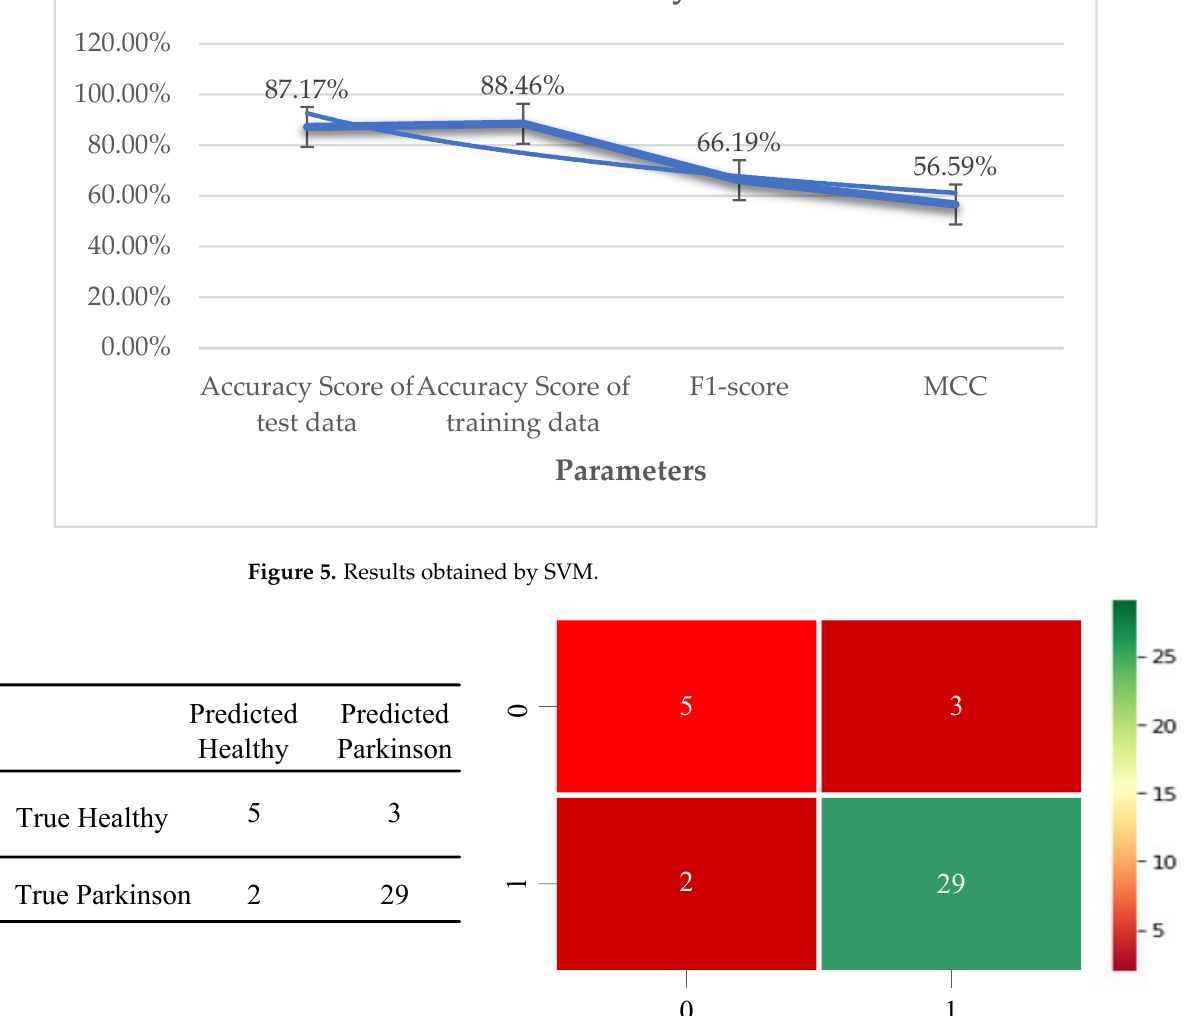
Figure 6. Confusion Matrix and Heatmap of SVM Classifier.